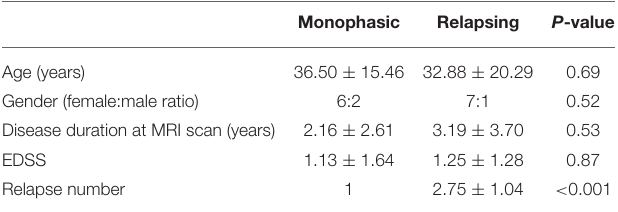
TABLE 1B | Clinical and demographic data of monophasic and relapsing MOGAD